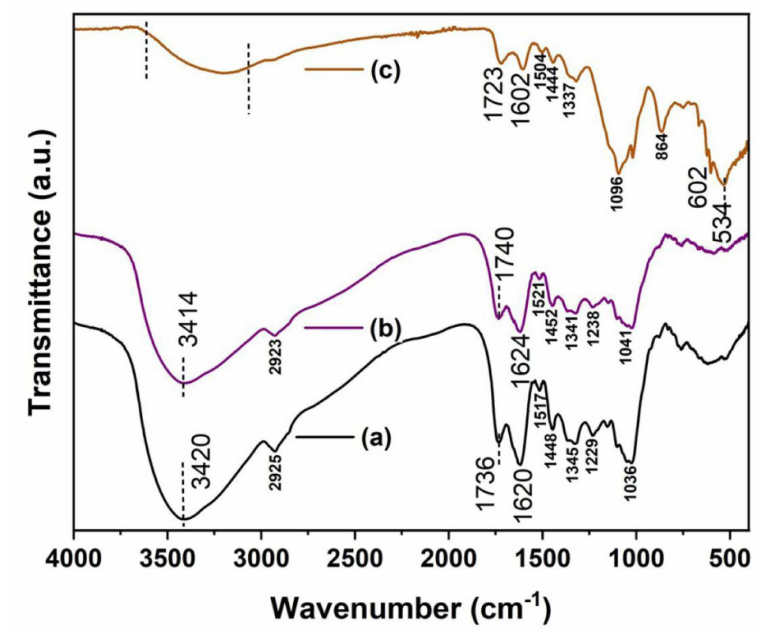
Figure 2. FT-IR spectra of ( a ) pomegranate peels powder ( b ) aqueous extract from pomegranate peels powder, and ( c ) Zn(OH) 2 /ZnO